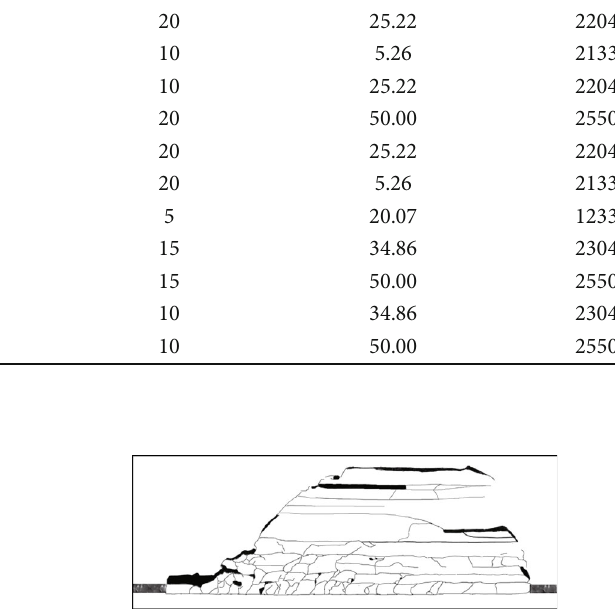
Figure 15: Distribution map of mining-induced fractures of no. 5 coal seam mining.